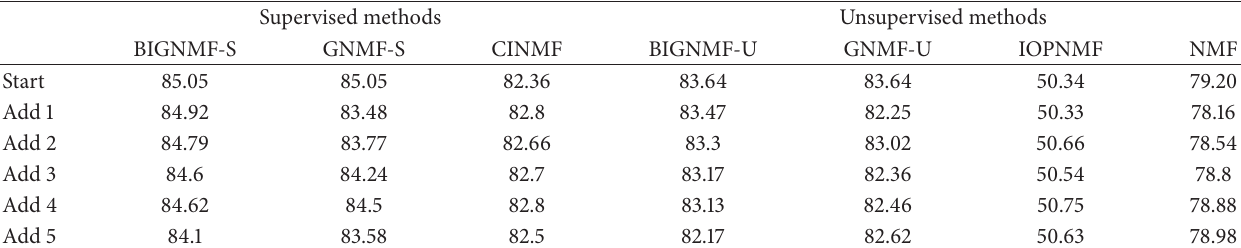
Table 2: The recognition rates (%) for the CMU-PIE database during adding 5 batches of images belonging to one class. Supervised methods